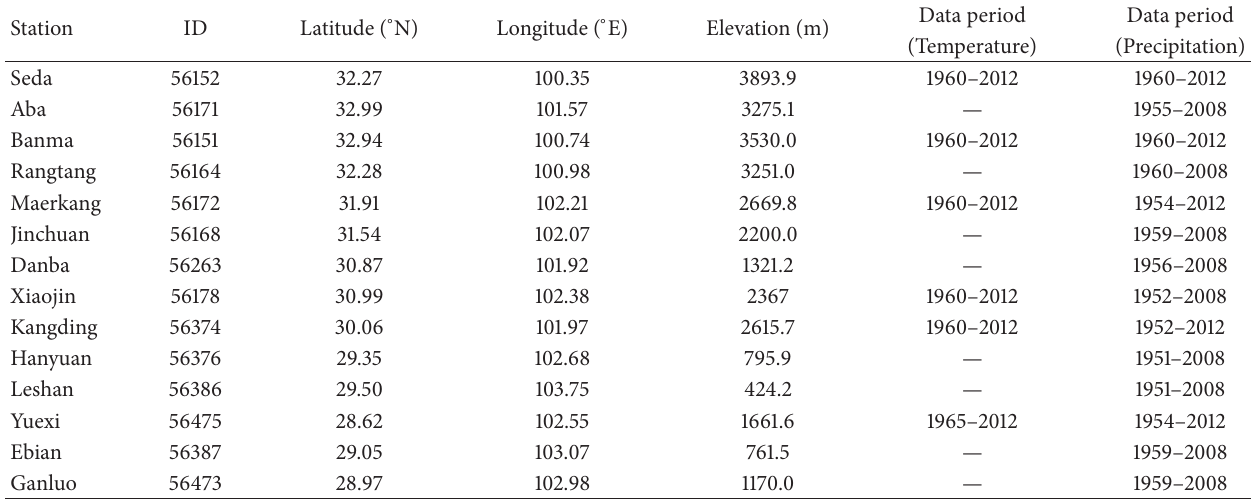
Table 1: Detailed information for meteorological